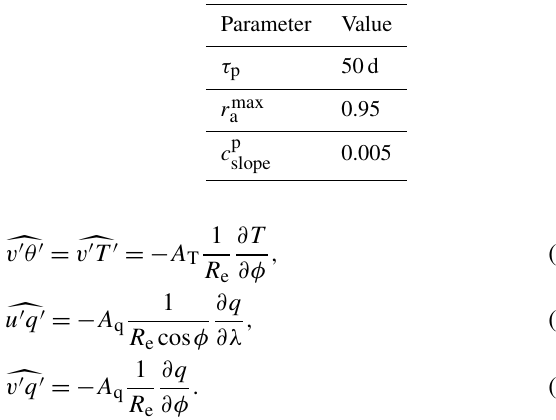
Table A3. Parameters for the hydrological cycle. Parameter